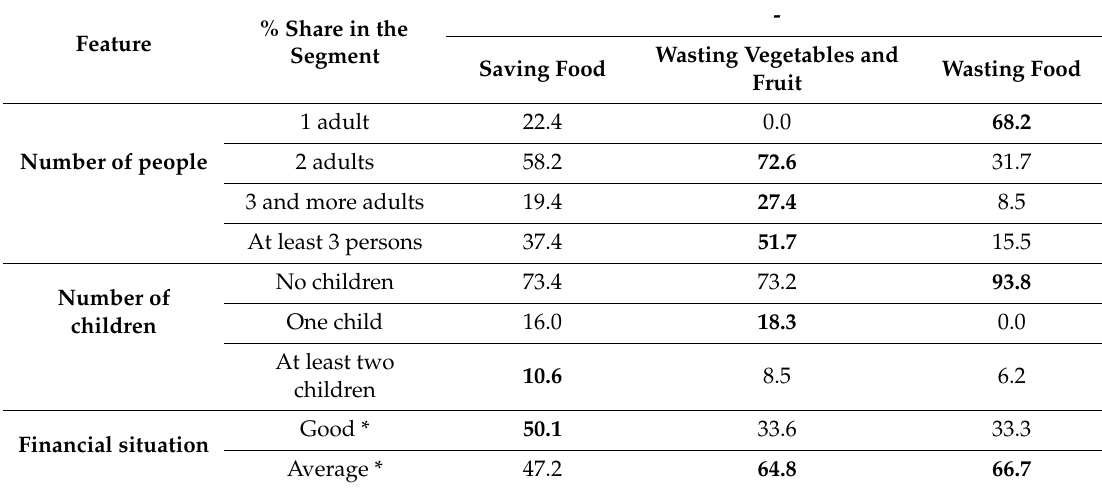
Table 2. Sociodemographic profile of